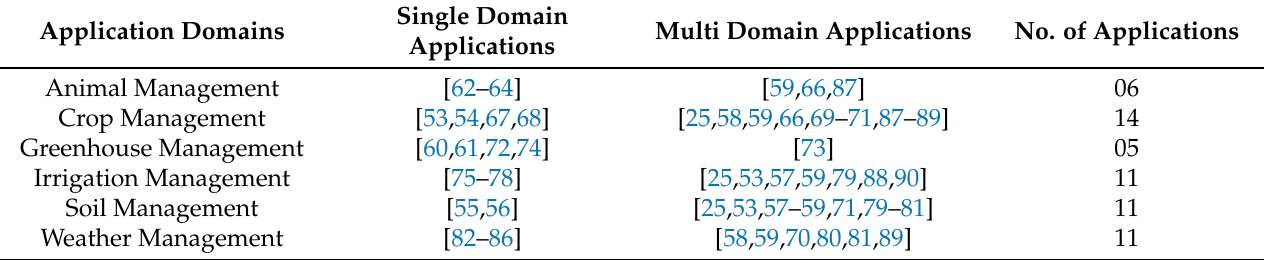
Table 4. Application